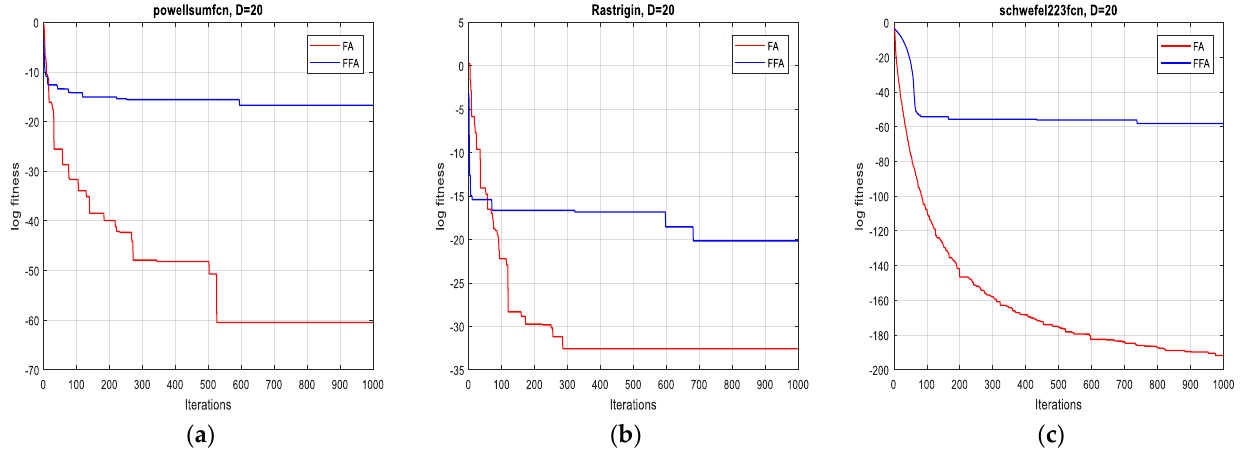
Figure 3. Convergence curves of FFA and FA for the functions: ( a ) F7; ( b ) F8 and ( c ) F9 (20D).